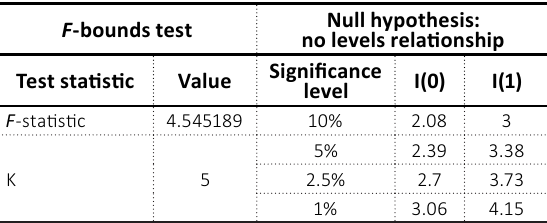
Table 2. Bound test result